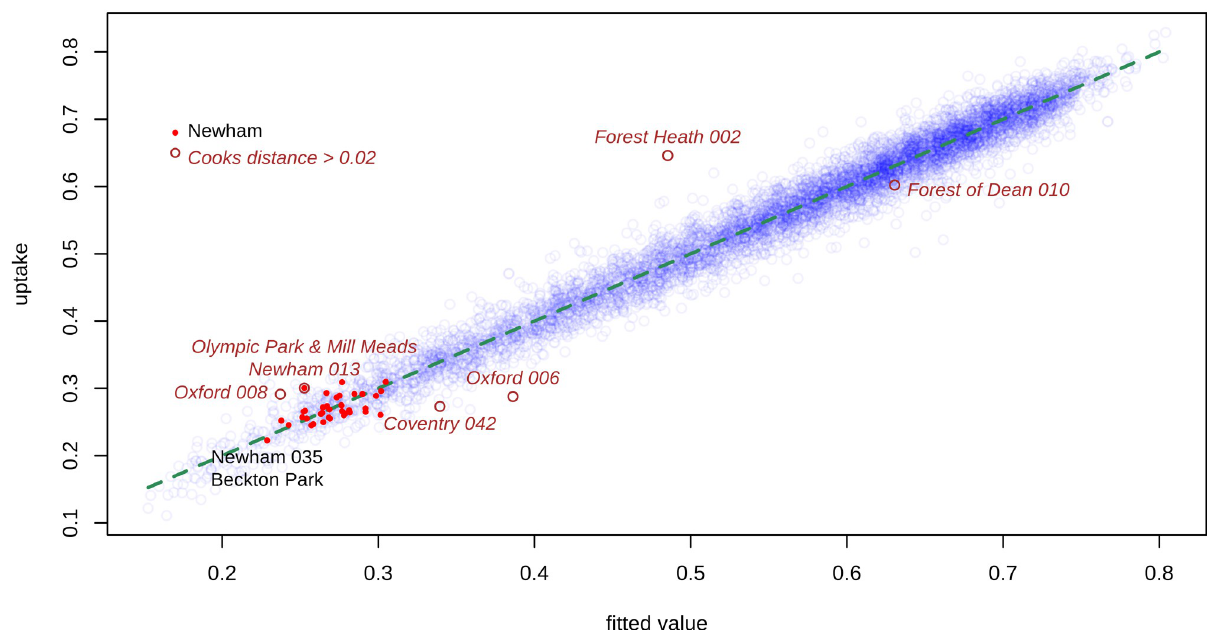
Fig 1. Fitted value versus uptake, model D for the Third Injection. Observed values of uptake are shown as semi-transparent blue points, and the green dashed line shows the fitted values. Outliers are shown in brown, and the Middle Super Output Areas within Newham in red. Vaccination data as of 4 January 2022. D is a Generalized Additive quasibinomial mixed model, with a random effect for Upper Tier Local Authority, and fixed effects as described in Statistical methods.